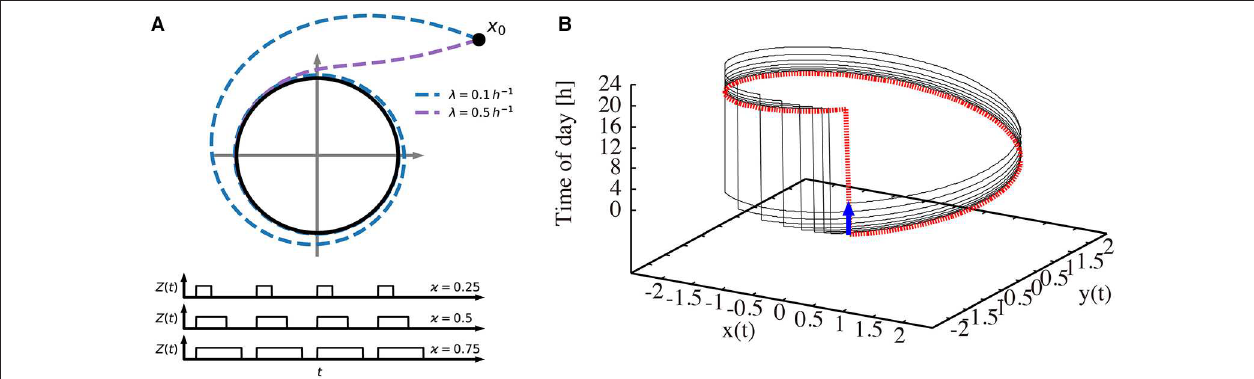
FIGURE 1 | Visualization of the amplitude-phase model. (A) Schematic illustration of the amplitude-phase oscillator model (top) Zeitgeber signals (bottom) of different photoperiods ̹ . Starting from the initial condition x 0 , a small relaxation rate ( λ = 0.1 h − 1 ) gives rise to a long transient until its convergence back to the limit cycle, while transients for large relaxation rates ( λ = 0.5 h − 1 ) are short. (B) The re-entrainment process of the oscillator after its phase is shifted by a 6 h-advanced jet lag (thin black line). The thick dotted red line represents the trajectory that the system converges to. The thick blue arrow indicates the 6 h jet lag.